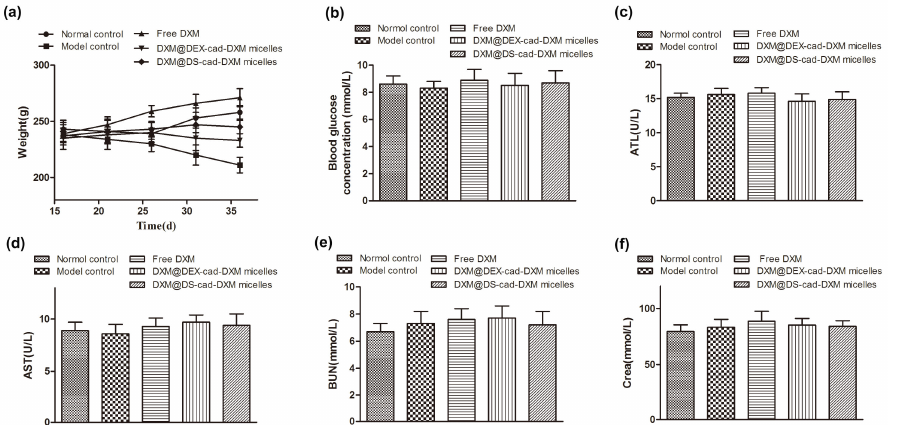
Figure 9. Safety assessment of DXM@DS-cad-DXM micelles and DXM@DEX-cad-DXM micelles in vivo after the treatment. Body weight ( a ), Blood glucose concentration ( b ), ALT ( c ), AST ( d ), BUN ( e ), and Crea ( f ) levels in